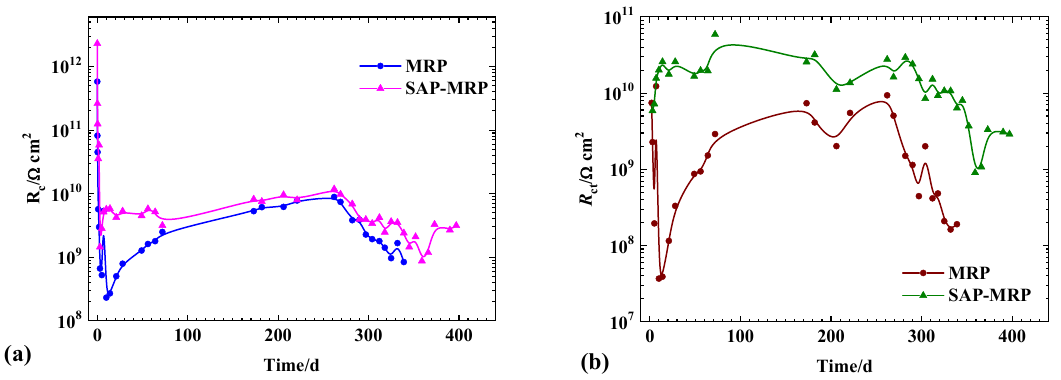
Figure 6. The changes of the obtained impedance parameters with time: ( a ) coating resistance, R c ; ( b ) charge-transfer resistance R ct .